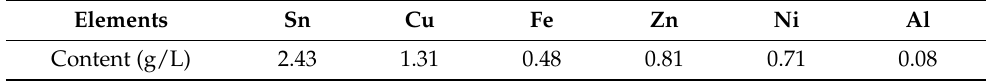
Table 5. The concentrations of various metals in the leach